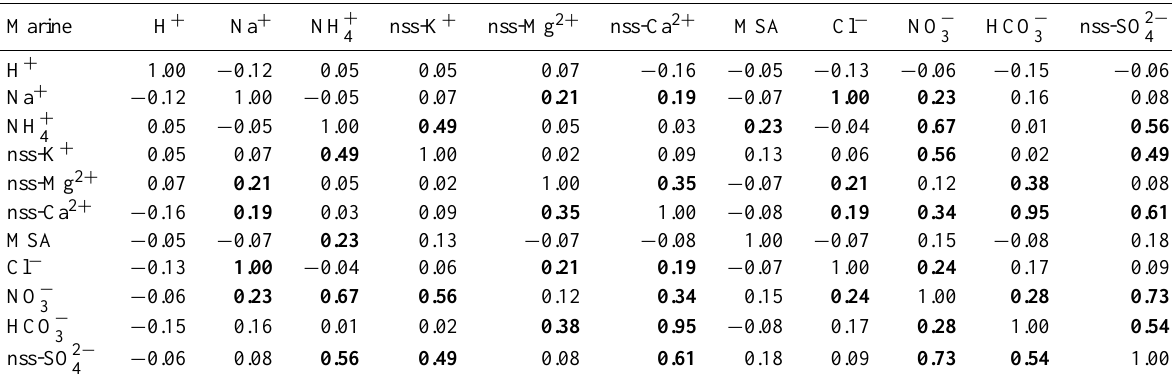
Table 2. Correlation coefficients for rainwater ionic components in the Marine trajectory group. Bold font indicates that the correlation is significant at 95%